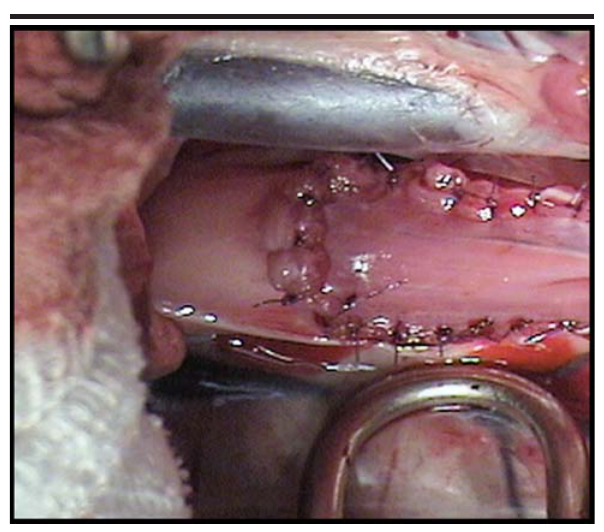
FIGURE 2 - Diaphragmatic flap sutured to the borders of the esophageal